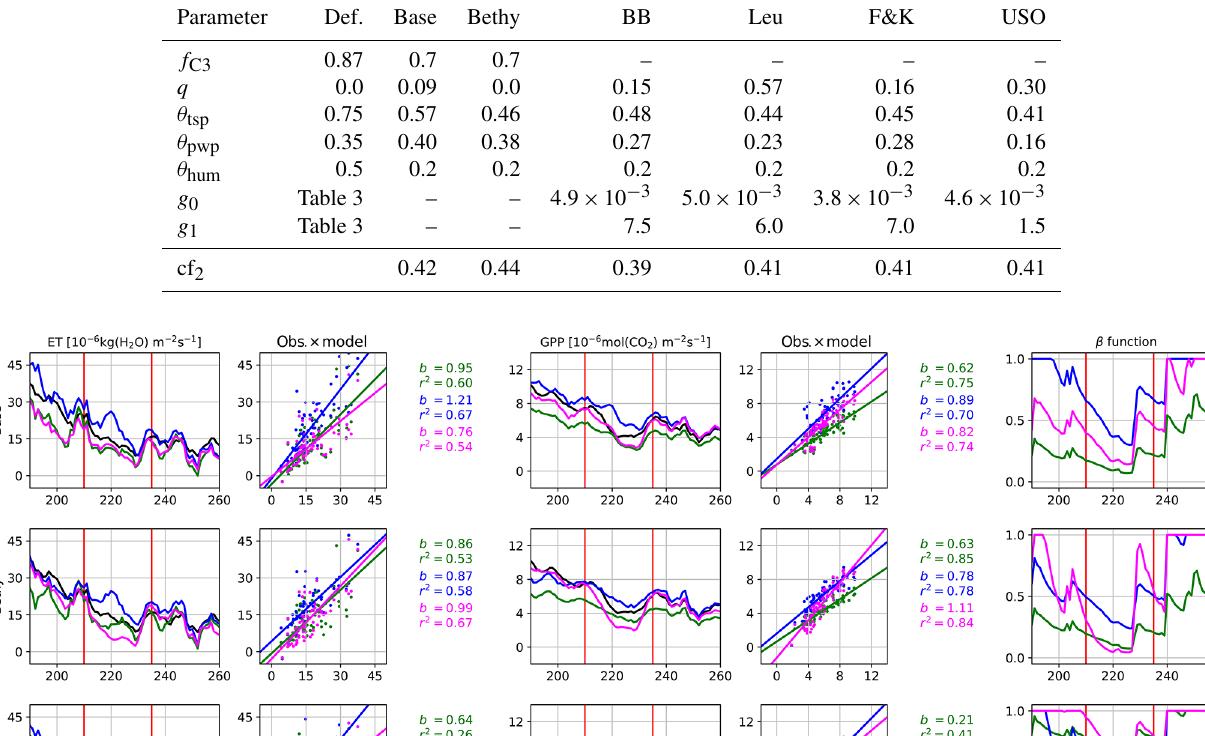
Table 7. Optimised parameter and corresponding cost function values with different stomatal conductance formulations for the extended dry period.